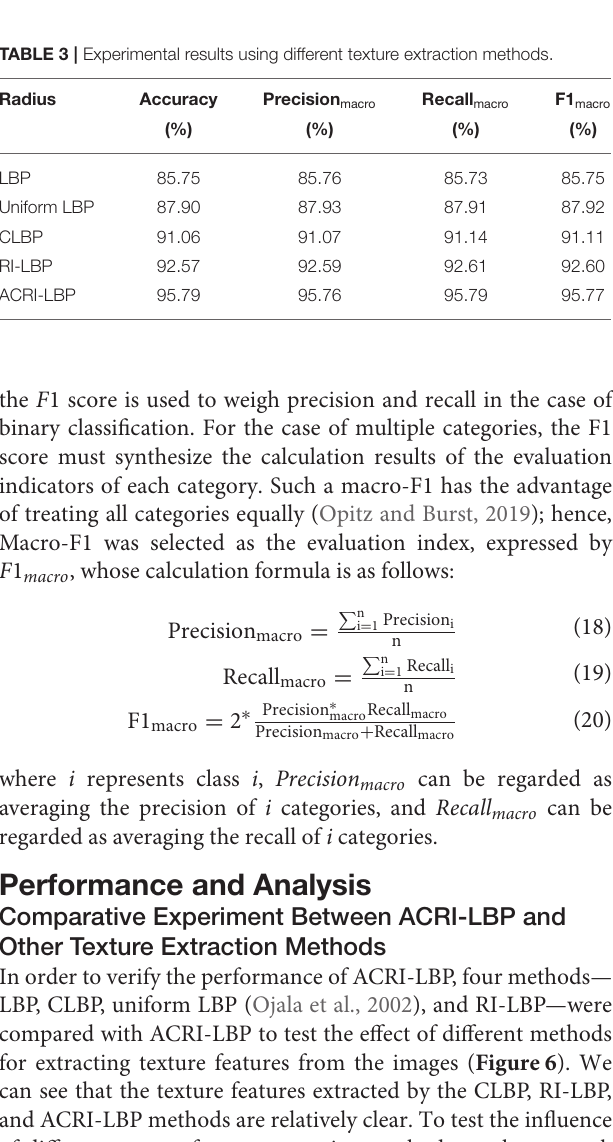
FIGURE 6 | Texture feature images extracted by different methods.